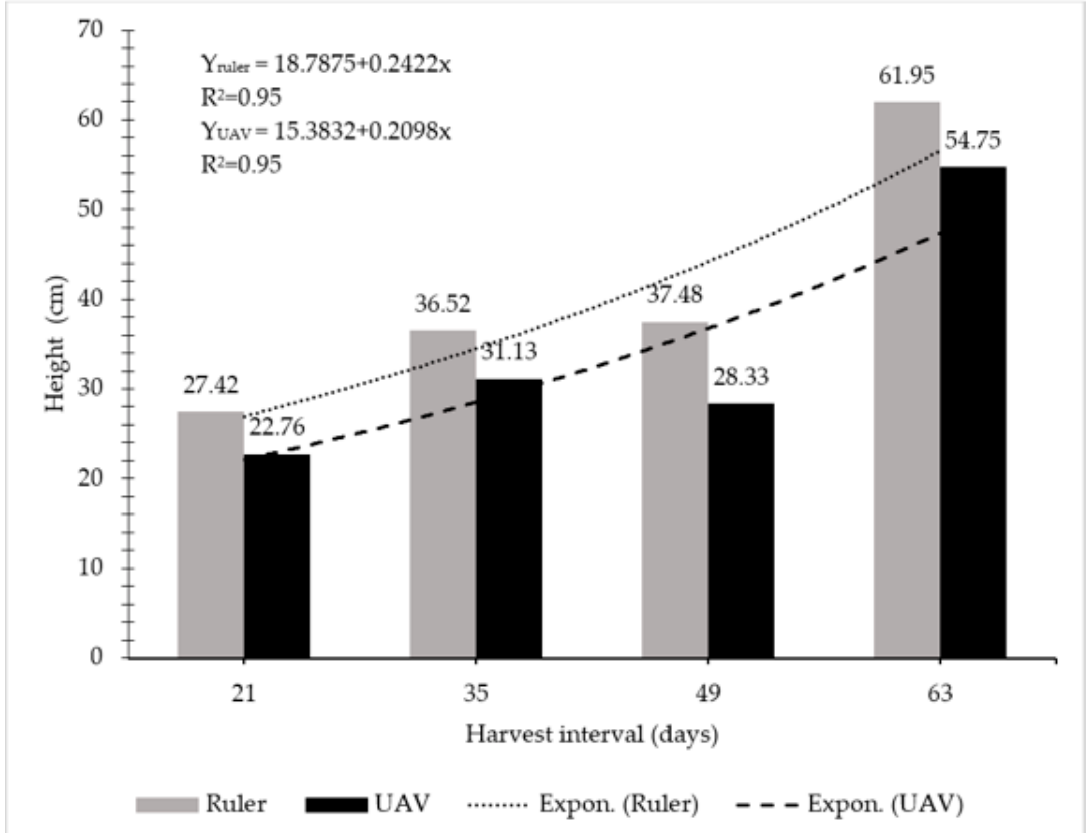
Figure 7. Height measured by the ruler and by the UAV at different harvest intervals.